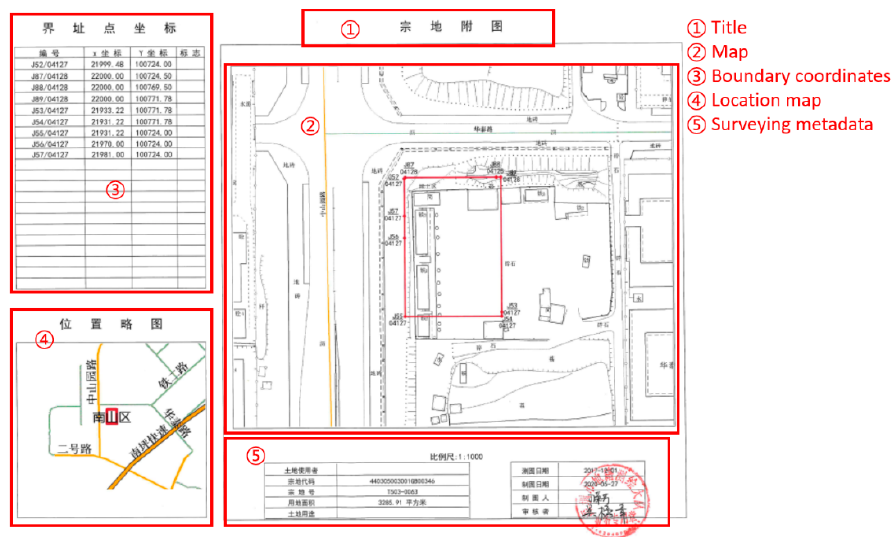
Figure 9. Parcel map of construction land (source: https://td.szggzy.com/tiaim/web/landDetail?